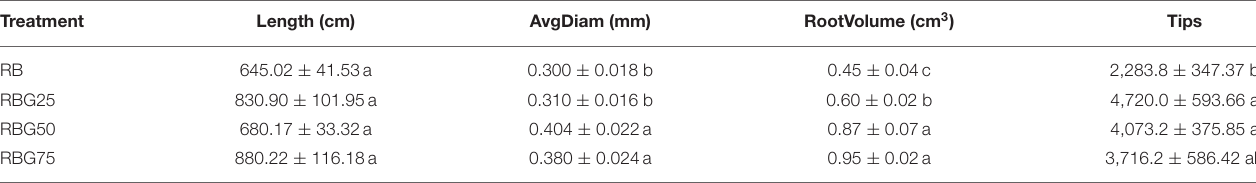
TABLE 4 | Effects of different light spectral conditions on total root length, average root diameter, total root volume, and root tip number of cucumber seedlings after 9 days of drought stress. Treatment